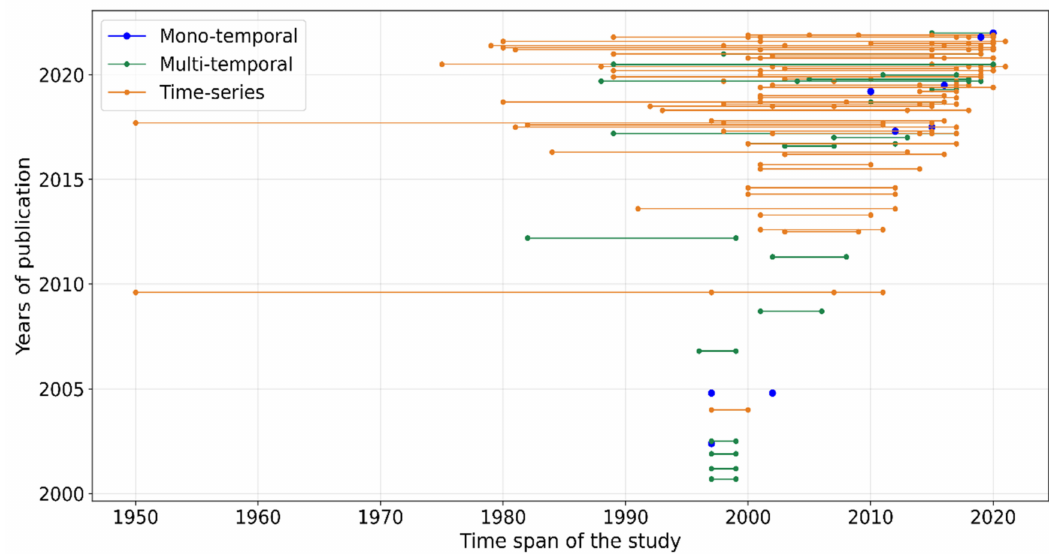
Figure 7. The articles in drought remote sensing, along with the reported investigated timeframe. The various colors represent mono-temporal (blue), multi-temporal (green), and time-series (dark yellow) studies,